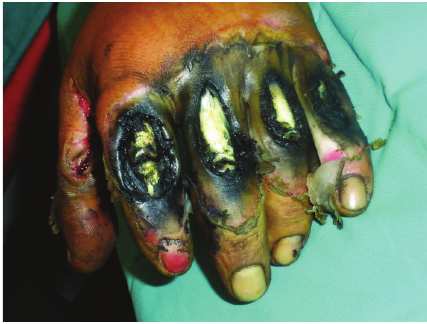
Figure 1: Left hand corn picker injury at admission to the hospital.